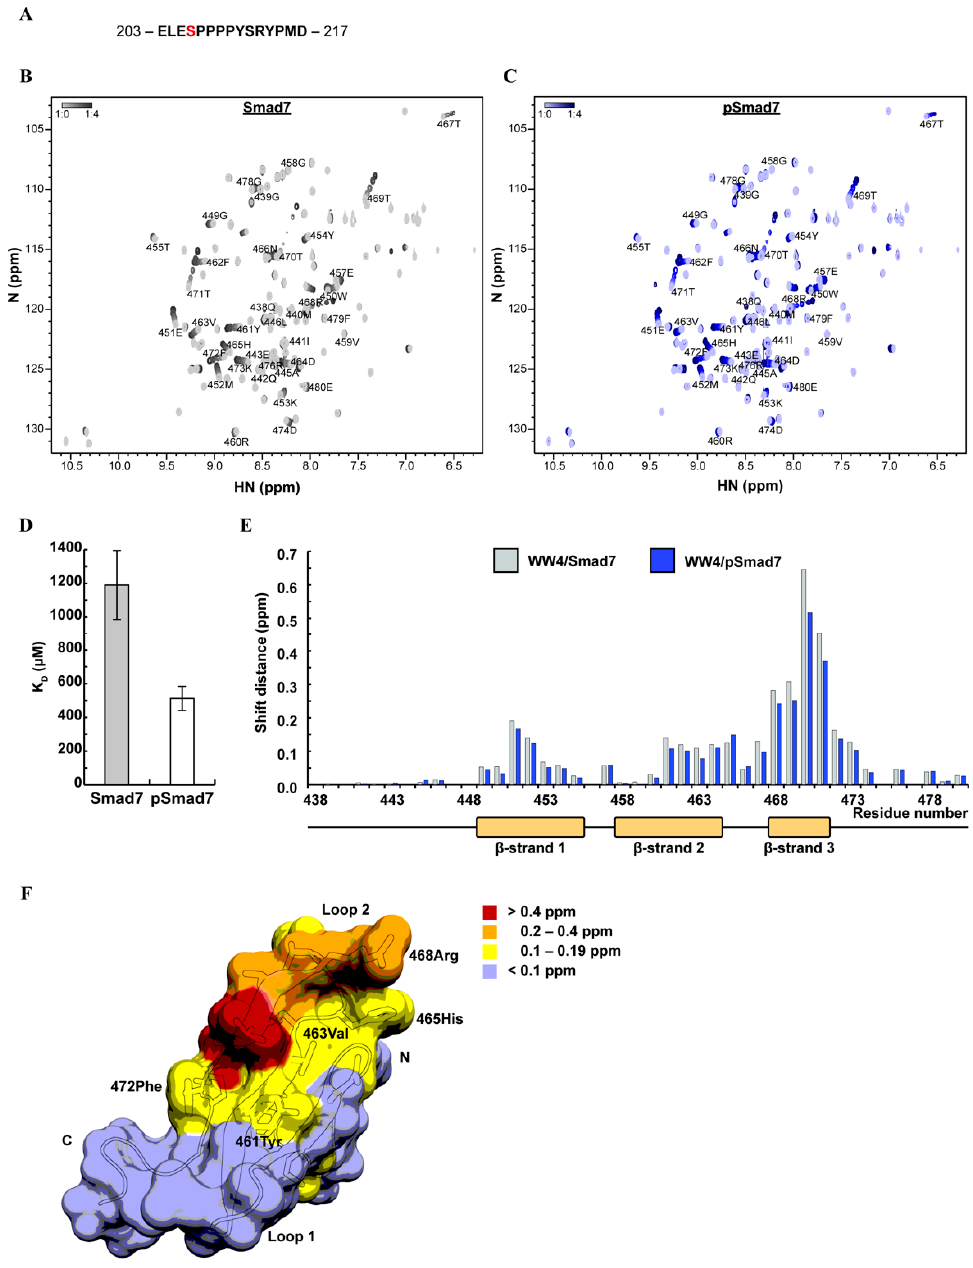
Figure 2. The interaction between WWP2 WW4 and Smad7 / S206-phosphorylated Smad7 (pSmad7). ( A ) The Smad7 ligand, with the PPxY motif in bold and the putative S206 phosphorylation site in red. ( B ) The superimposed WW4 / Smad7 titration heteronuclear single quantum coherence (HSQCs). Lower ligand concentrations are in light grey, and higher ligand concentrations are in dark grey. ( C ) The superimposed WW4 / pSmad7 titration HSQCs. Lower ligand concentrations are in light blue, and higher ligand concentrations are in dark blue. ( D ) The WW4 / Smad7 (1.19 ± 0.21 mM) and WW4 / pSmad7 (0.5 ± 0.07 mM) dissociation constants. ( E ) The shift distances of the WW4 / Smad7 and WW4 / pSmad7 titration HSQC amide peaks in ppm. The WW4 secondary structure is aligned to the residue number along the x-axis, with β -strands represented as orange boxes. ( F ) The WWP2 WW4 domain structure with Smad7 binding site residues colour-coded for titration shift distances. The labelled residues are the XP-binding groove (472Phe and 461Tyr) and the second specificity pocket (463Val, 465His and 468Arg), which determine specificity for the PPxY recognition